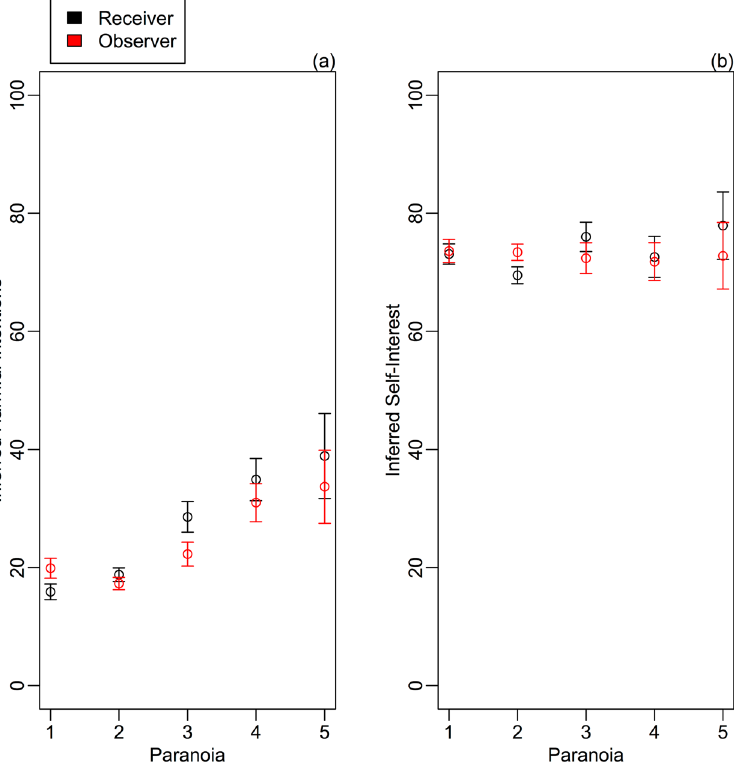
Figure 1. Attributions of ( a ) harmful intent and ( b ) self-interest for dictators as a function of paranoia ideation. Black circles represent attributions made in the receiver role; red circles represent attributions made in the observer role. Means and standard errors are generated from raw data. For visualisation, paranoia here is shown as a 5-level categorical dummy variable (where 1 ≤ 35 ; 36 < 2 ≤ 60 ; 61 < 3 ≤ 85 ; 86 < 4 ≤ 110 ; 111 < 5 ≤ 160 ). Please note: In the statistical analyses, paranoia is treated as a continuous term (though analyses are robust when paranoia is included as a categorical